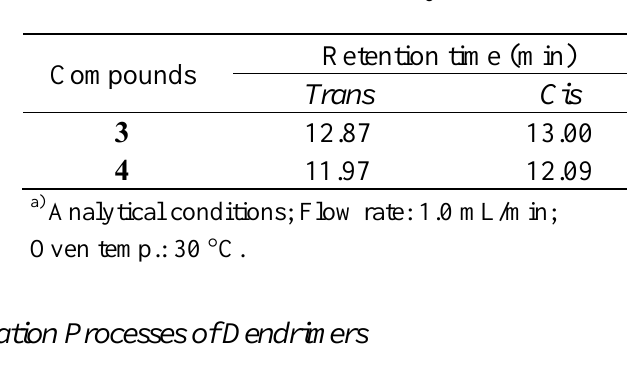
Table 2. Results of GPC analyses a) of 3 and 4 .